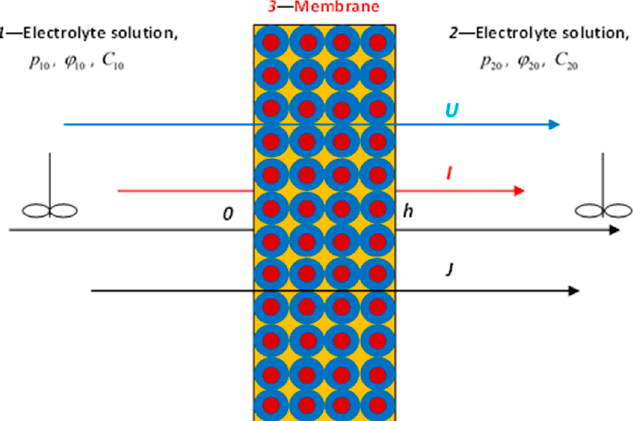
Figure 1. Diagram of the electrolyte solution transfer through a charged membrane.